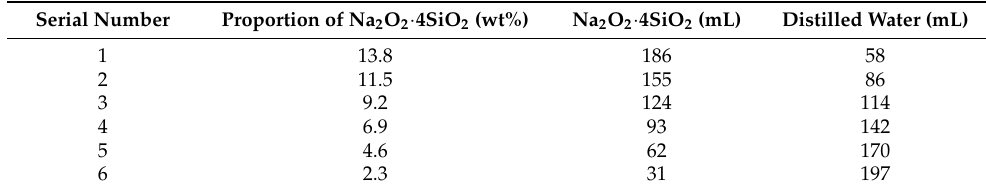
Table 2. Dosage of sodium silicate solution and distilled water for different composite alkali-acti- vated cementitious materials.